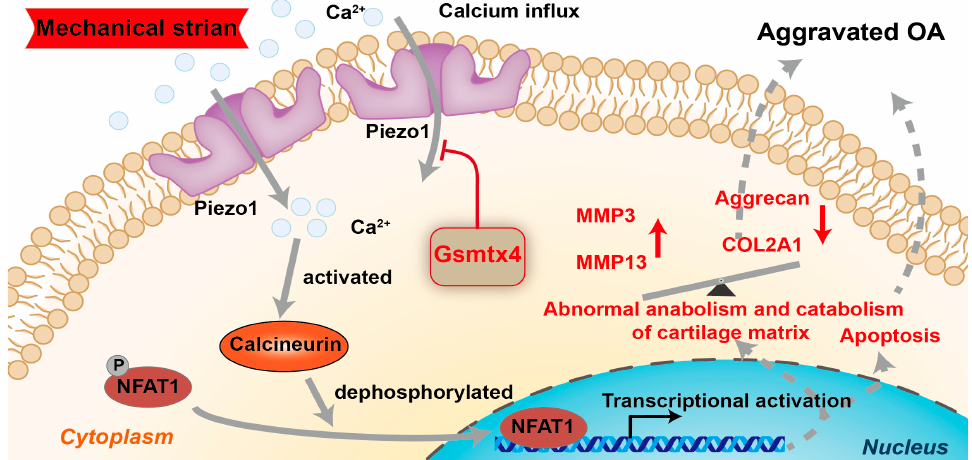
Figure 8. Schematic diagram representing the molecular mechanism by which Gsmtx4 alleviated OA under excessive mechanical strain.